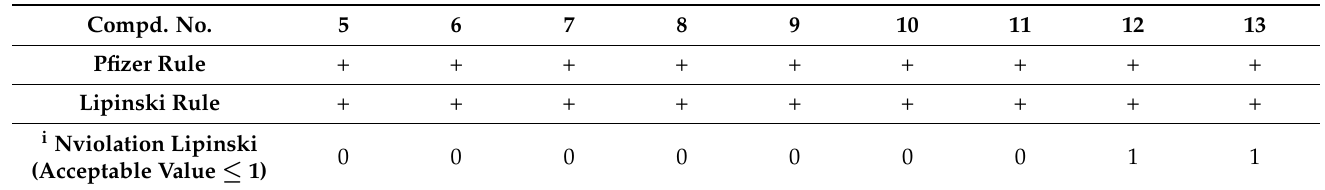
Table 3. Predicted medicinal chemistry properties and the Lipinski parameters for the target com- pounds 5 – 13 .